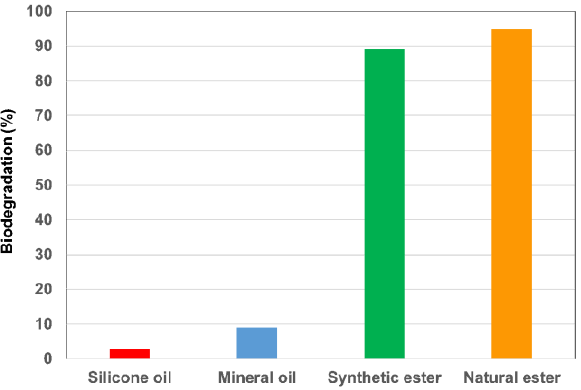
Figure 6. Biodegradation rate of different insulating fluids.